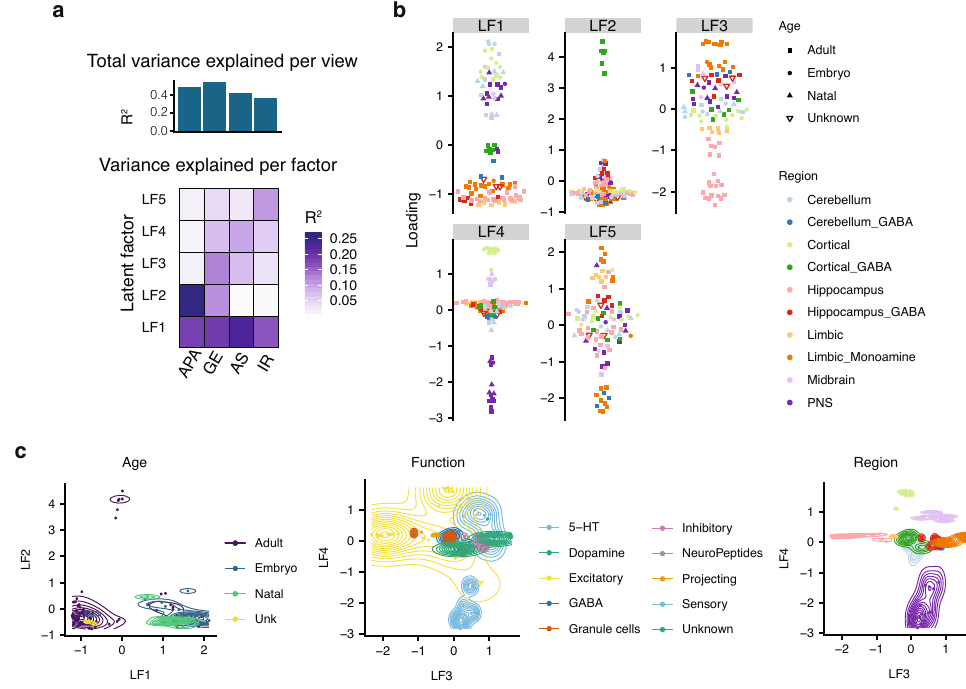
Fig. 4 Expanded analysis of whole-brain reveals coordinated regulation by all layers. a Summary of latent factors inferred by MOFA and the contributions of each layer to each factor (see Fig. 1b for details). b Beeswarm plots illustrating the variation described by the latent factors inferred by MOFA (see Fig. 1c for description of Beeswarm plots). c Combined scatter and contour plots comparing the loadings for pairs of latent factors: LF1 versus LF2 (left), LF3 versus LF5 (middle and right). The contours indicate the density of cell types for a speci fi c attribute. In particular, age is a highly correlated with LF1 (left), excitatory neurons are correlated with LF3 (middle), and PNS neurons are correlated with LF4 (right). unk = LF2 signi fi cantly overlapped with this set of genes (27/66, p = 3.85 × 10 − 5 , hypergeometric test; Fig. 3e, f). These results indicate that changes in the length of 3 ′ UTRs between the proximal-distal axis, relative to other hippocampal axes, are likely coupled to transcript regulation through differential localization 47 .